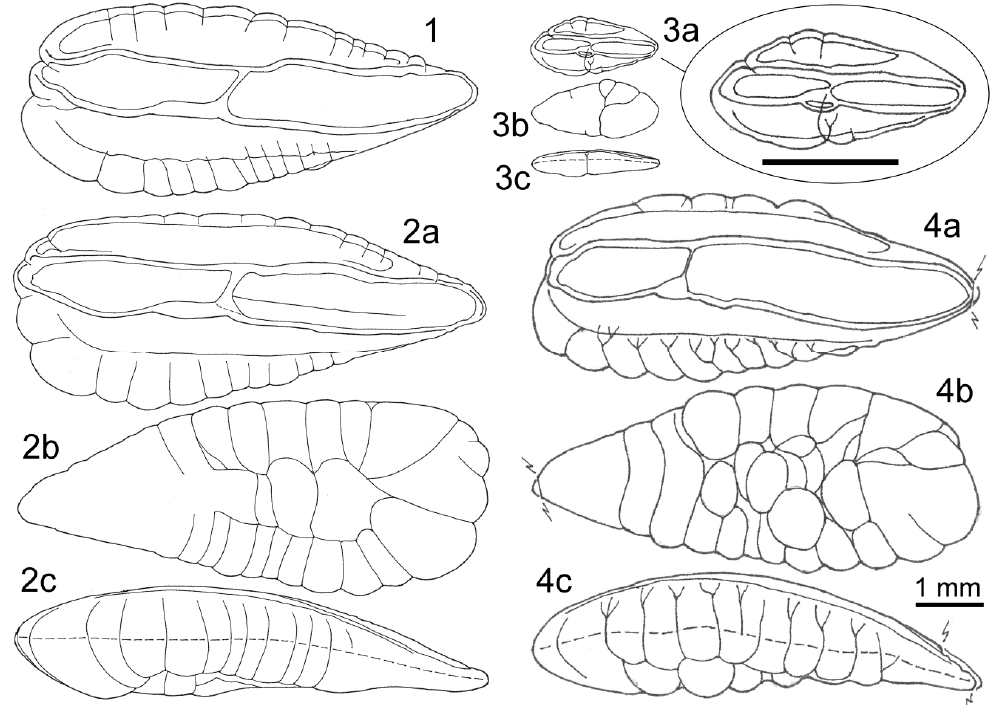
Figure 2. Differences between otolith morphology of Neocolliolus and Trisopterus . ( 1 ) Neocolliolus esmarkii , Recent, North Sea, TL 159, OL 6.85, coll. Mardik Leopold, number EU25; ( 2a – c ) Neocolliolus esmarkii , Recent, North Sea, TL 157, OL 7.07, coll. Mardik Leopold, number EU22; ( 3a – c ) Neocolliolus esmarkii , Recent, North Sea, TL 46, OL 1.715, mirror image, coll. Mardik Leopold, number CB1; ( 4a – c ) New subspecies of Trisopterus capelanus , Early Miocene, Behrendorfian, Berchem Formation, Kiel Sands, borehole airfield Haamstede, The Netherlands, 132–133 m below surface, mirror image.